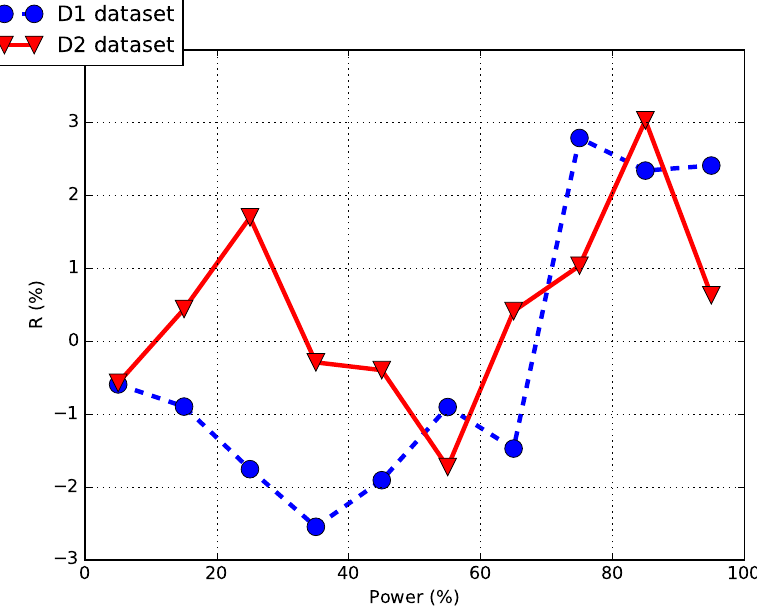
Figure 3. The average difference between measurements and simulation (Equation (1)) of the power of T7, for data sets D1 and D2 and for a sample run of the